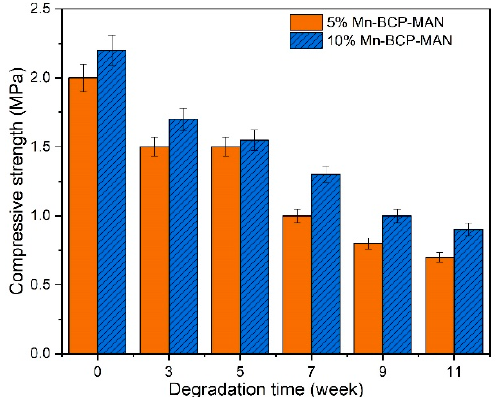
Figure 4. Compressive strength of the scaffolds.